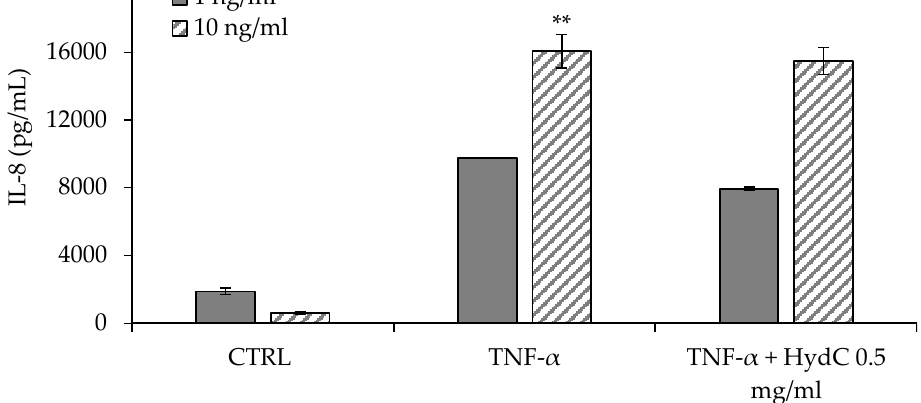
Figure 6. Quantification of IL-8 in HTB-4 cell supernatants after a 24-h stimulation with TNF- α 1 ng/mL (positive control) or TNF- α 1 ng/mL + HydC (HA: 0.5 mg/mL) and with TNF- α 10 ng/mL (positive control) or TNF- α 10 ng/mL + HydC (HA: 0.5 mg/mL) (* p < 0.05; *** p < 0.0001). CTRL: HTB-4 in basal medium.